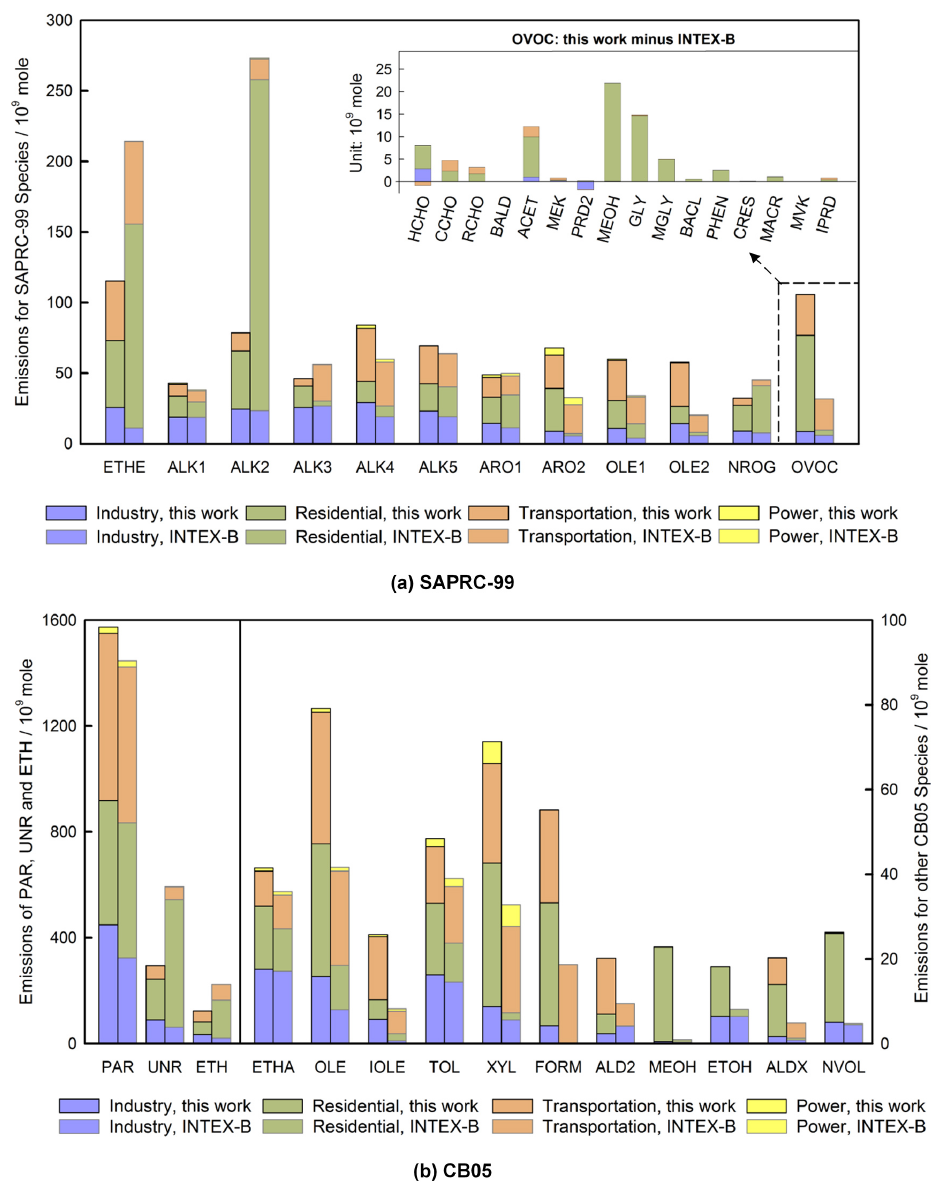
Figure 10. 2006 Asian anthropogenic NMVOC emissions by SAPRC-99 (a) and CB05 (b) species. An explanation of the abbreviations of SAPRC-99 and CB05 emitting species are presented in Tables A1 and